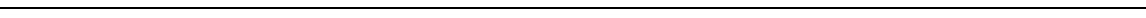
Fig. 2 Hlx regulates thermogenic gene expression and mitochondrial biogenesis in adipocyte culture. a Brown preadipocytes were infected with Hlx knockdown lentiviruses and differentiated. Western blot analysis of Hlx protein and immunostaining of C/ebp α were performed. Green , C/ebp α ; blue , DAPI. Scale bar , 200 µ m. N.S. indicates a nonspeci fi c band. b Brown adipocytes generated as in ( a ) were either untreated or treated with Forskolin for 6 h,